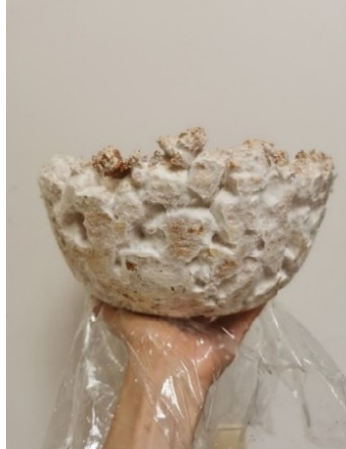
Figure 9. Mycelium-based composite: rough texture, deriving from substrate fragmentation (design and photo: A. Bonenberg).